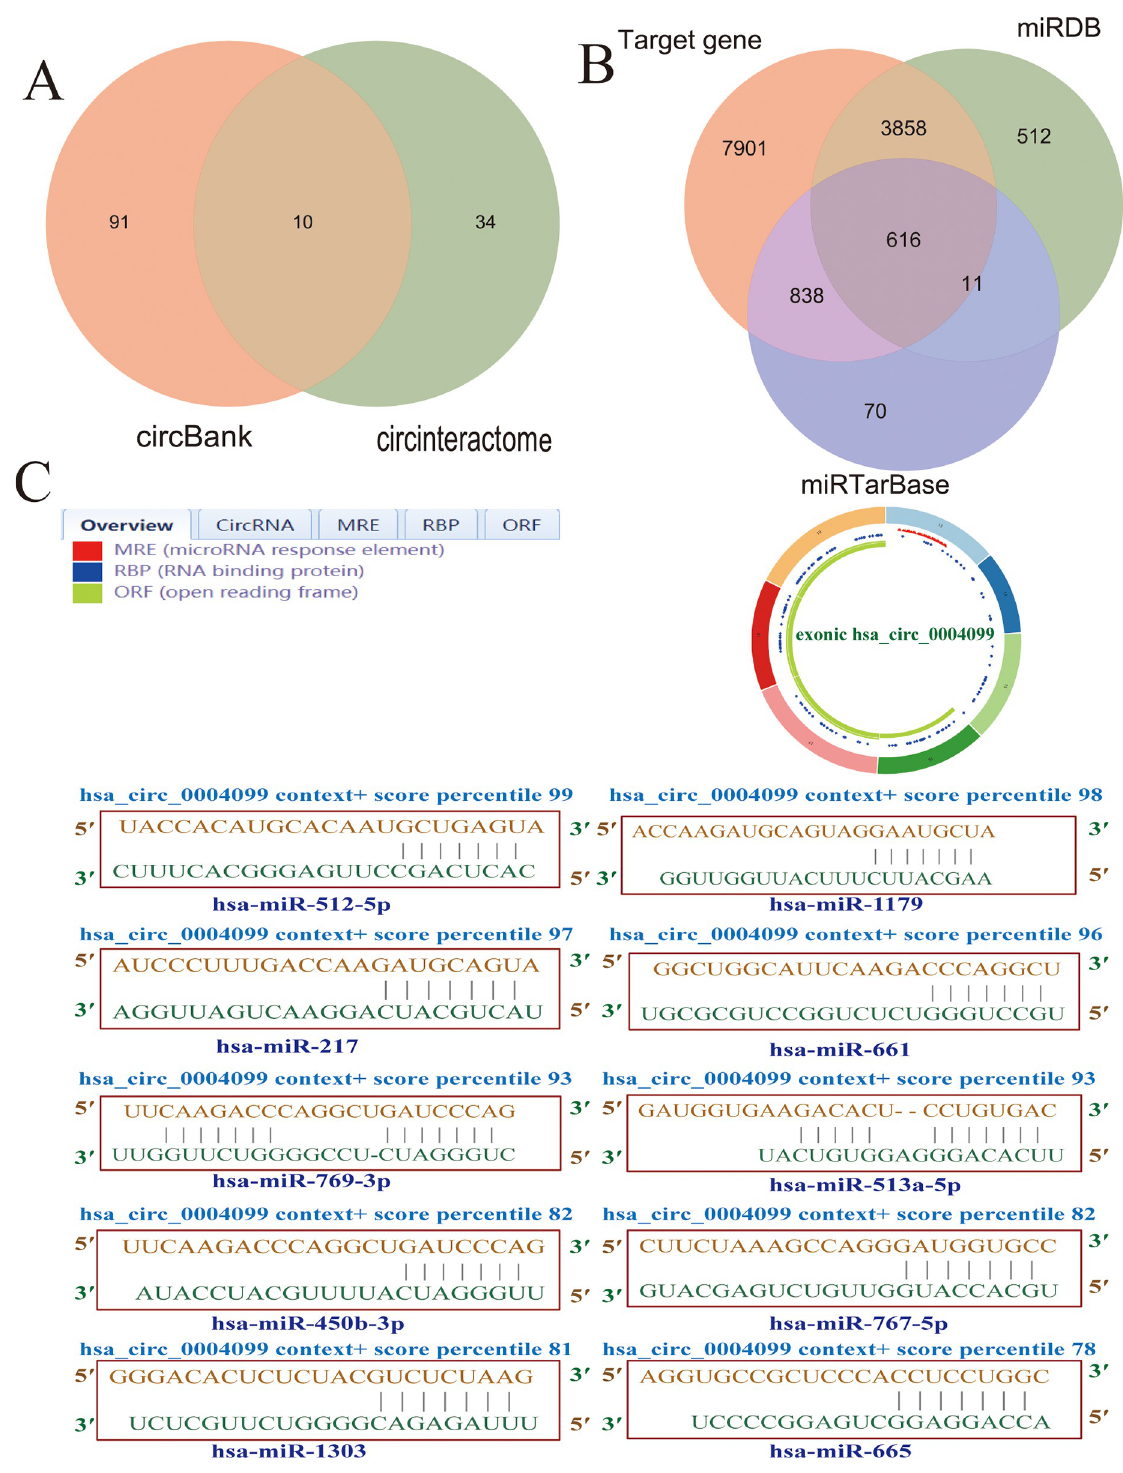
Fig 4. Downstream of hsa_circ_0004099 intersecting microRNAs (miRNAs) and mRNAs. A: Ten intersecting miRNAs predicted using the circular RNA Interactom and circBank. B: Ten miRNAs predicted 616 intersecting mRNAs. C: CSCD identified the miRNA-response elements (MRE), RNA-binding proteins (RBP), and open reading frames (ORF) of hsa_circ_0004099, which obtained the binding score of hsa_circ_0004099 and the intersection of 10 miRNAs; the closer the value was to 100, the higher was the confidence.